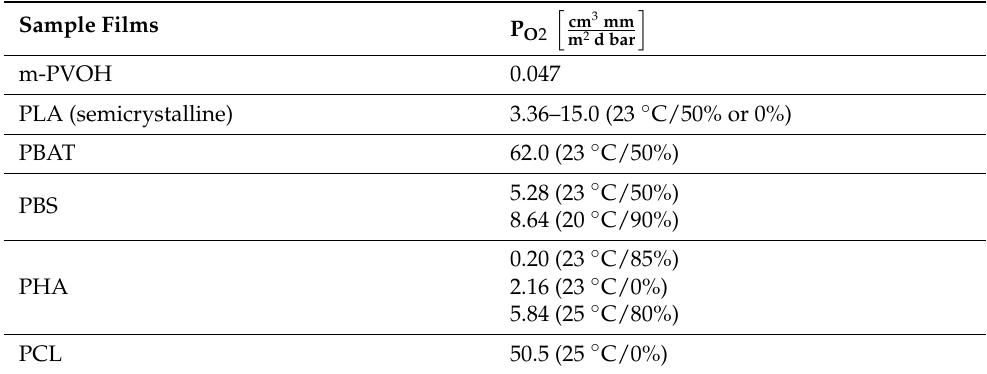
Table 5. Oxygen permeability of the m-PVOH single-coating layer, calculated in this study, and of other biodegradable materials (calculated values from Wu et al., 2021